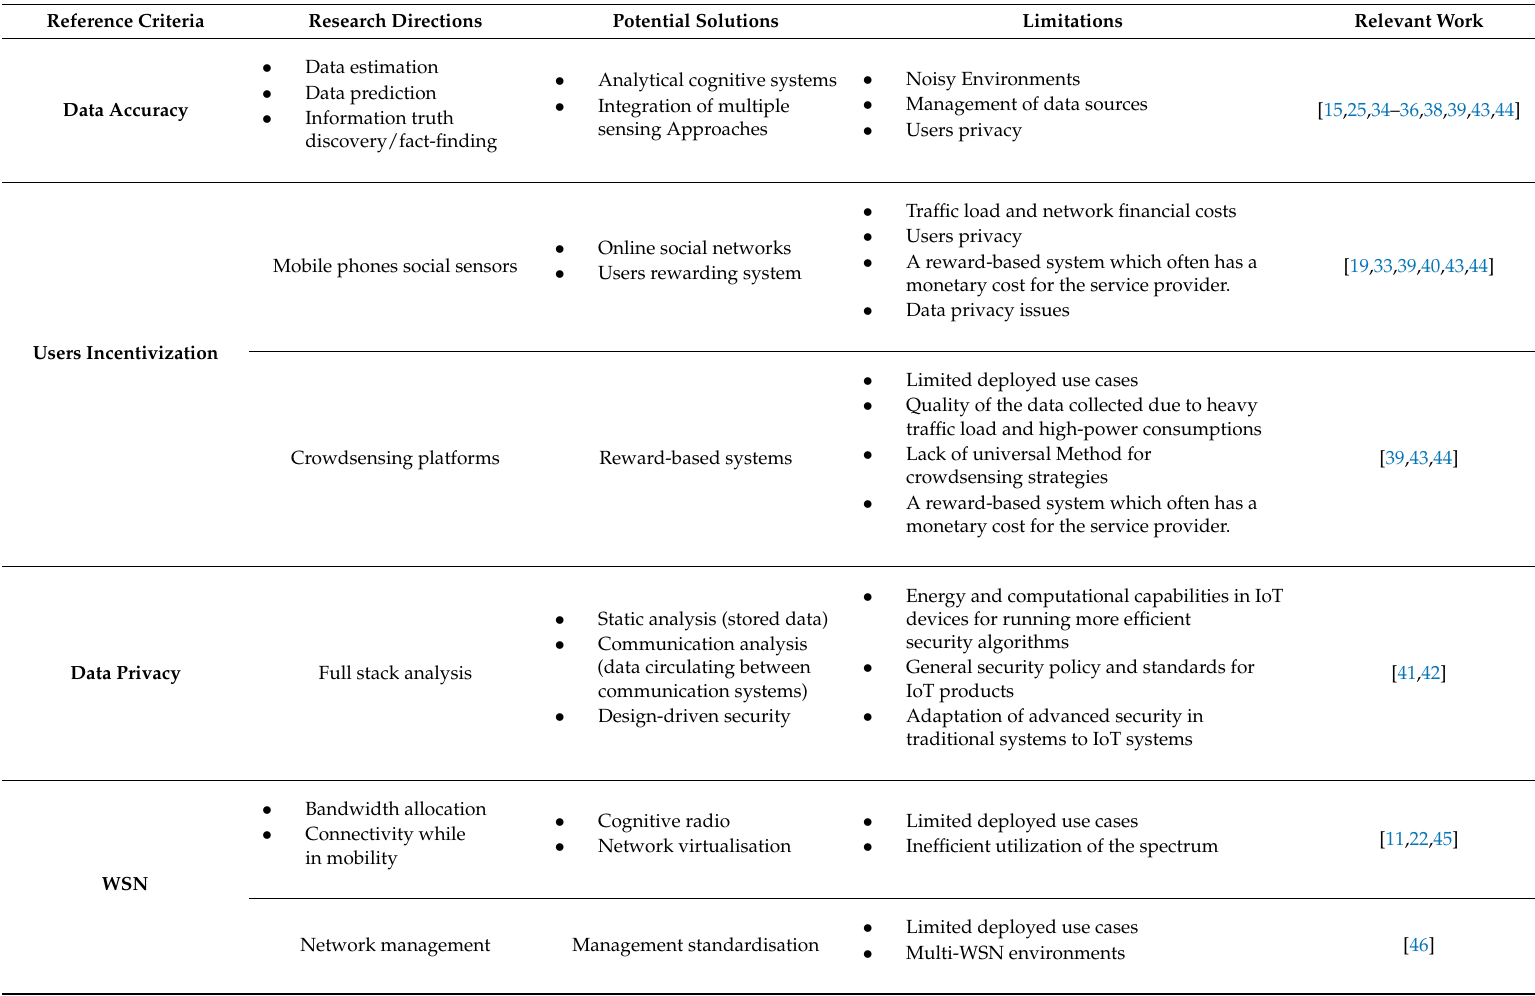
Table 4. Main open challenges identified in the